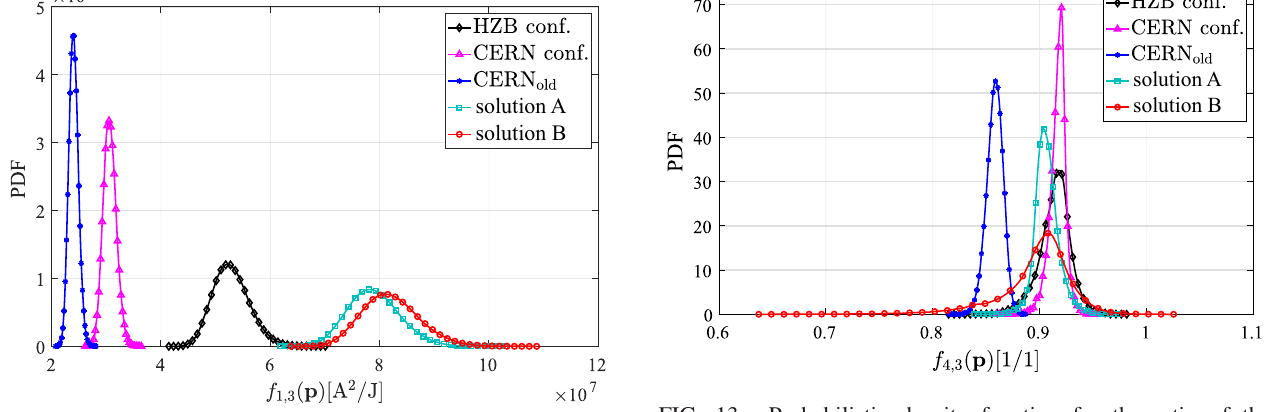
FIG. 10. Probabilistic density function for the focusing factor.